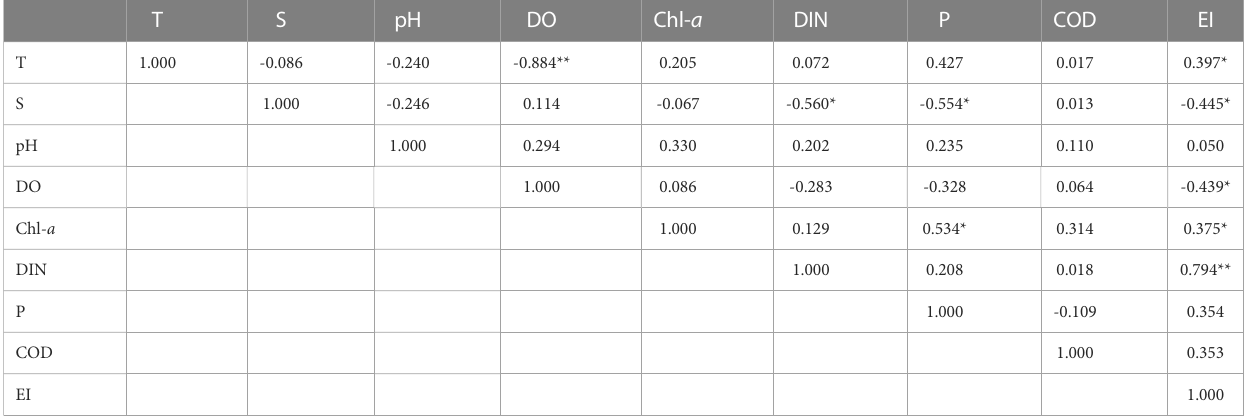
TABLE 2 Correlation between eutrophication index and environment factors in Zhanjiang